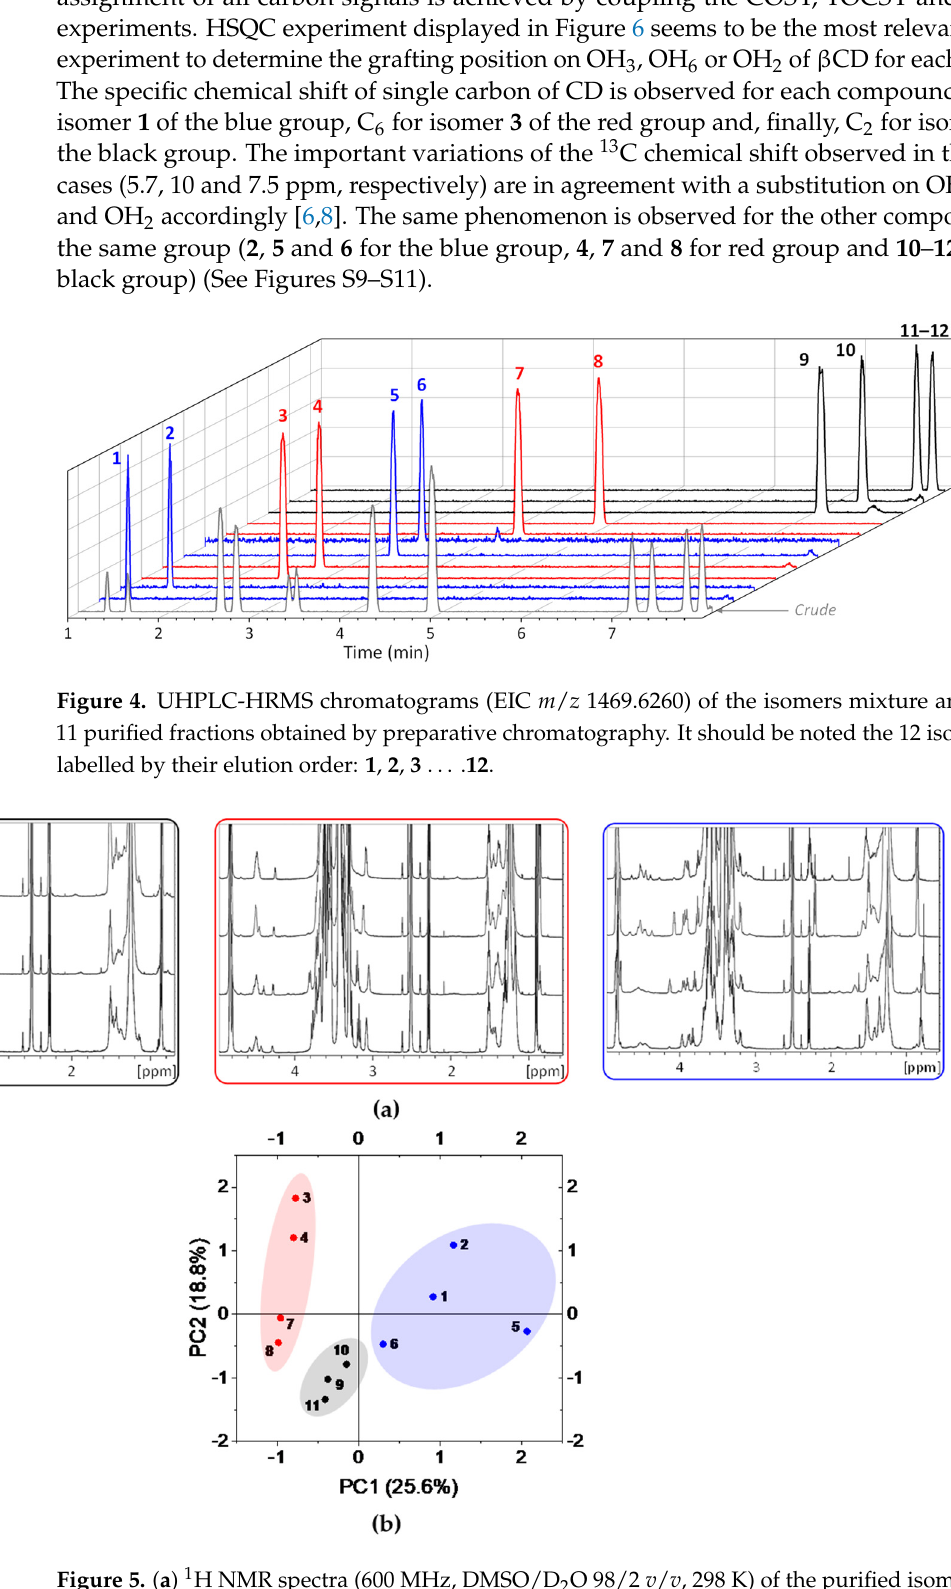
Figure 6. Partial contour plot of 1 H- 13 C HSQC experiments (600 MHz, DMSO/D 2 O 98/2, v / v , 298 K) of isomers 1 ( a ), 3 ( b ) and 9 ( c ). ( d ) EIC of Lip β CD marked with the regioisomers assignment based on HSQC experiments.